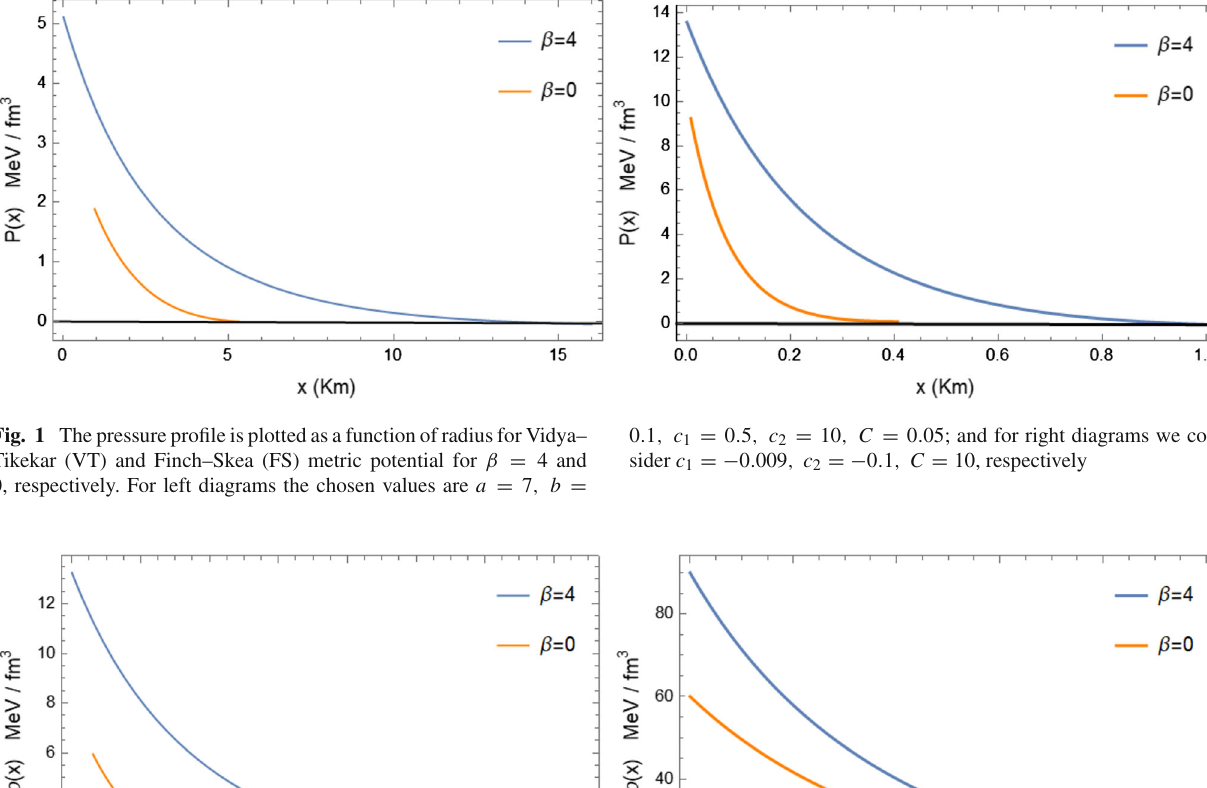
Fig. 2 Variation of energy density as a function of the radial coordinate x for compact star. The labels of the curves are the same as given in Fig. 1